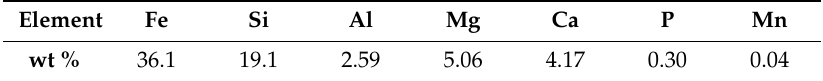
Table 1. The major elemental composition of the ore. Element Fe Si